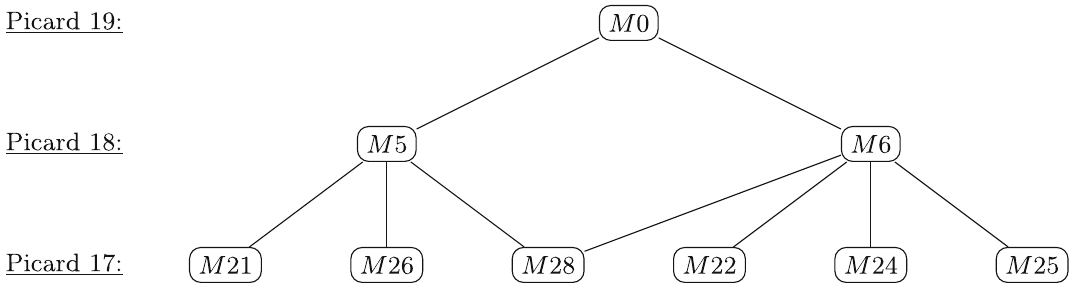
Fig. 3 Polytopes up to 3 complex parameters that are linked to M 0 by removing points in their M lattice (i.e. a monomial in the hypersurface equation)